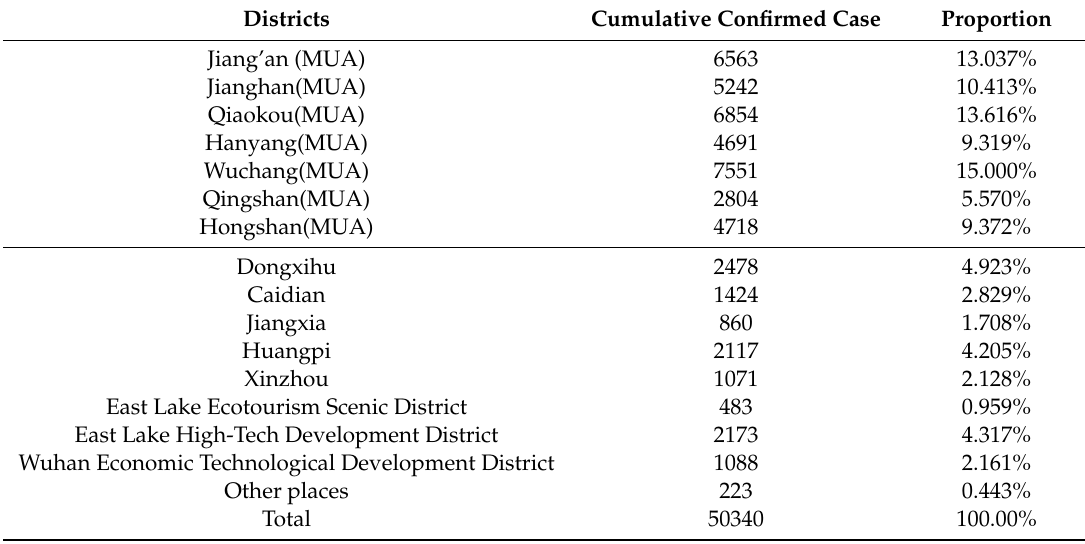
Table 1. Case statistics of Wuhan. (As of June 11th, 2020 source: Wuhan Municipal Commission of